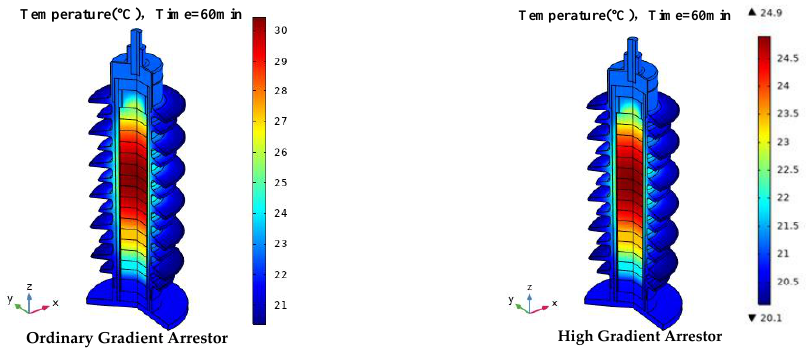
Figure 9. Temperature distribution of 60 min high-gradient and ordinary-gradient arrestor under power frequency voltage.